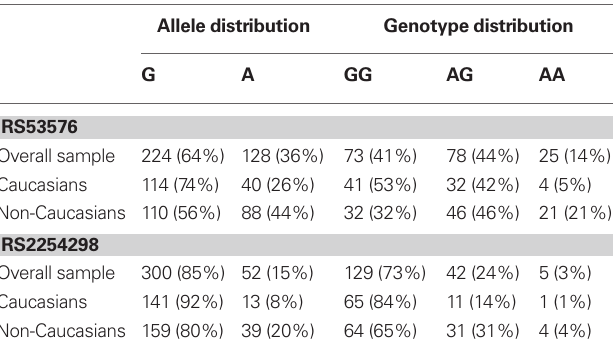
Table 1 | Allele and genotype frequencies of OXTR